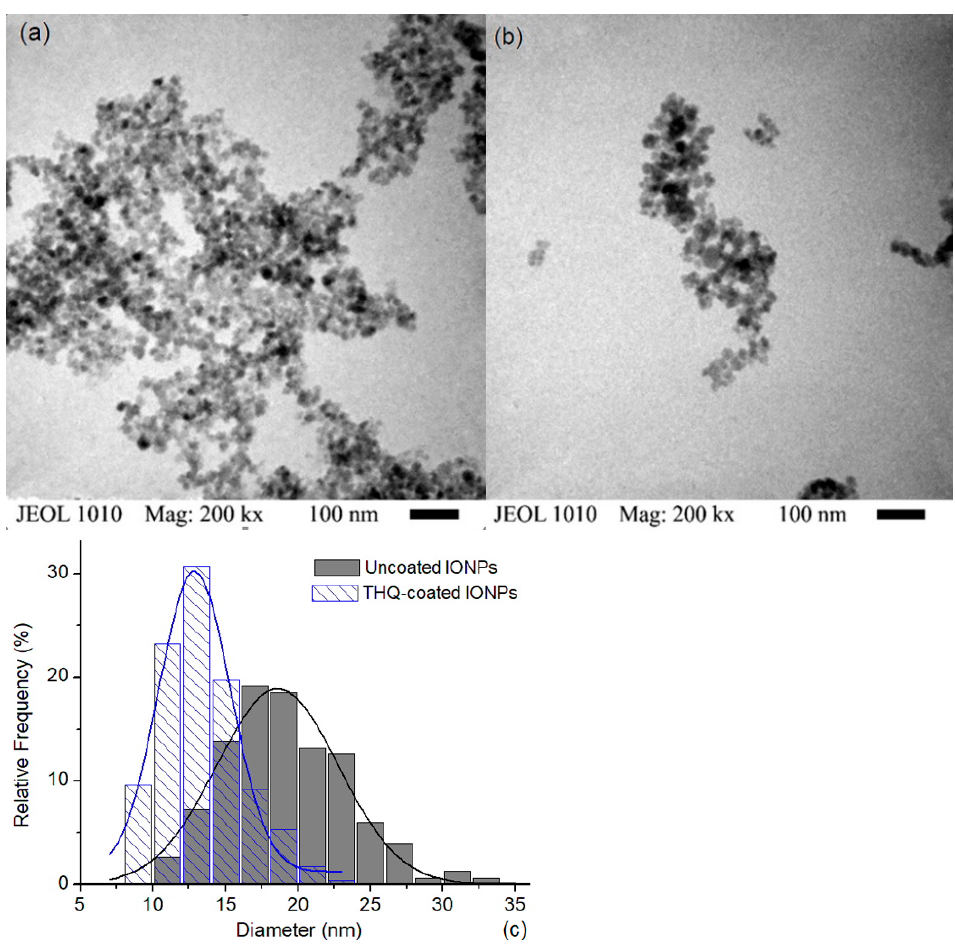
Figure 2. Typical micrographs of uncoated IONPs ( a ), THQ-coated IONPs ( b ) and the corresponding size distribution plot ( c ).